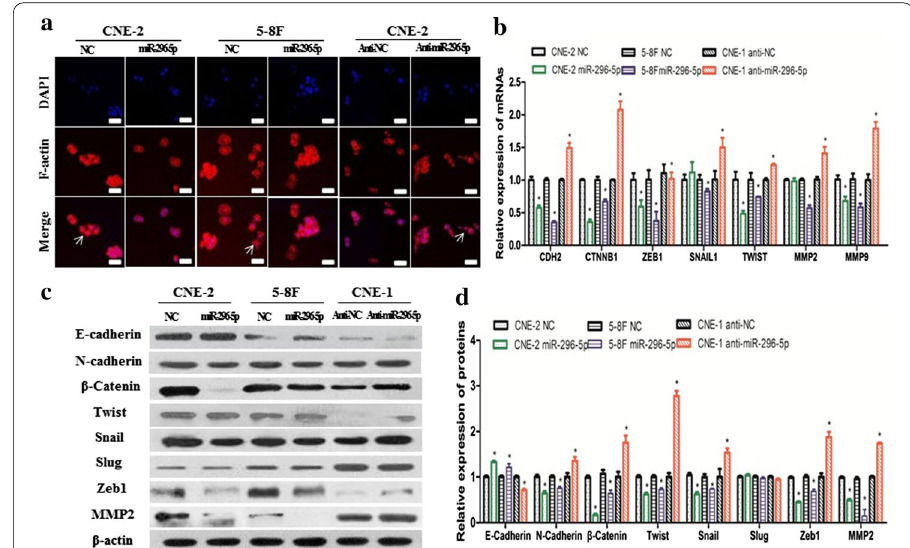
Fig. 3 MiR-296-5p inhibits the metastasis of NPC cells by regulating EMT. a Immunofluorescence showed miR-296-5p expression affected the morphological changes of NPC cells from the epithelial to mesenchymal type. Scale bar 100 µm. b Real-time PCR showed that miR-296-5p expression affected the expression of the EMT-related markers in NPC cells. c Western blotting showed miR-296-5p affected the expression of the EMT-related markers in NPC cells. d The relative expression levels of the EMT-related proteins with gray-scale analysis. *p < 0.05